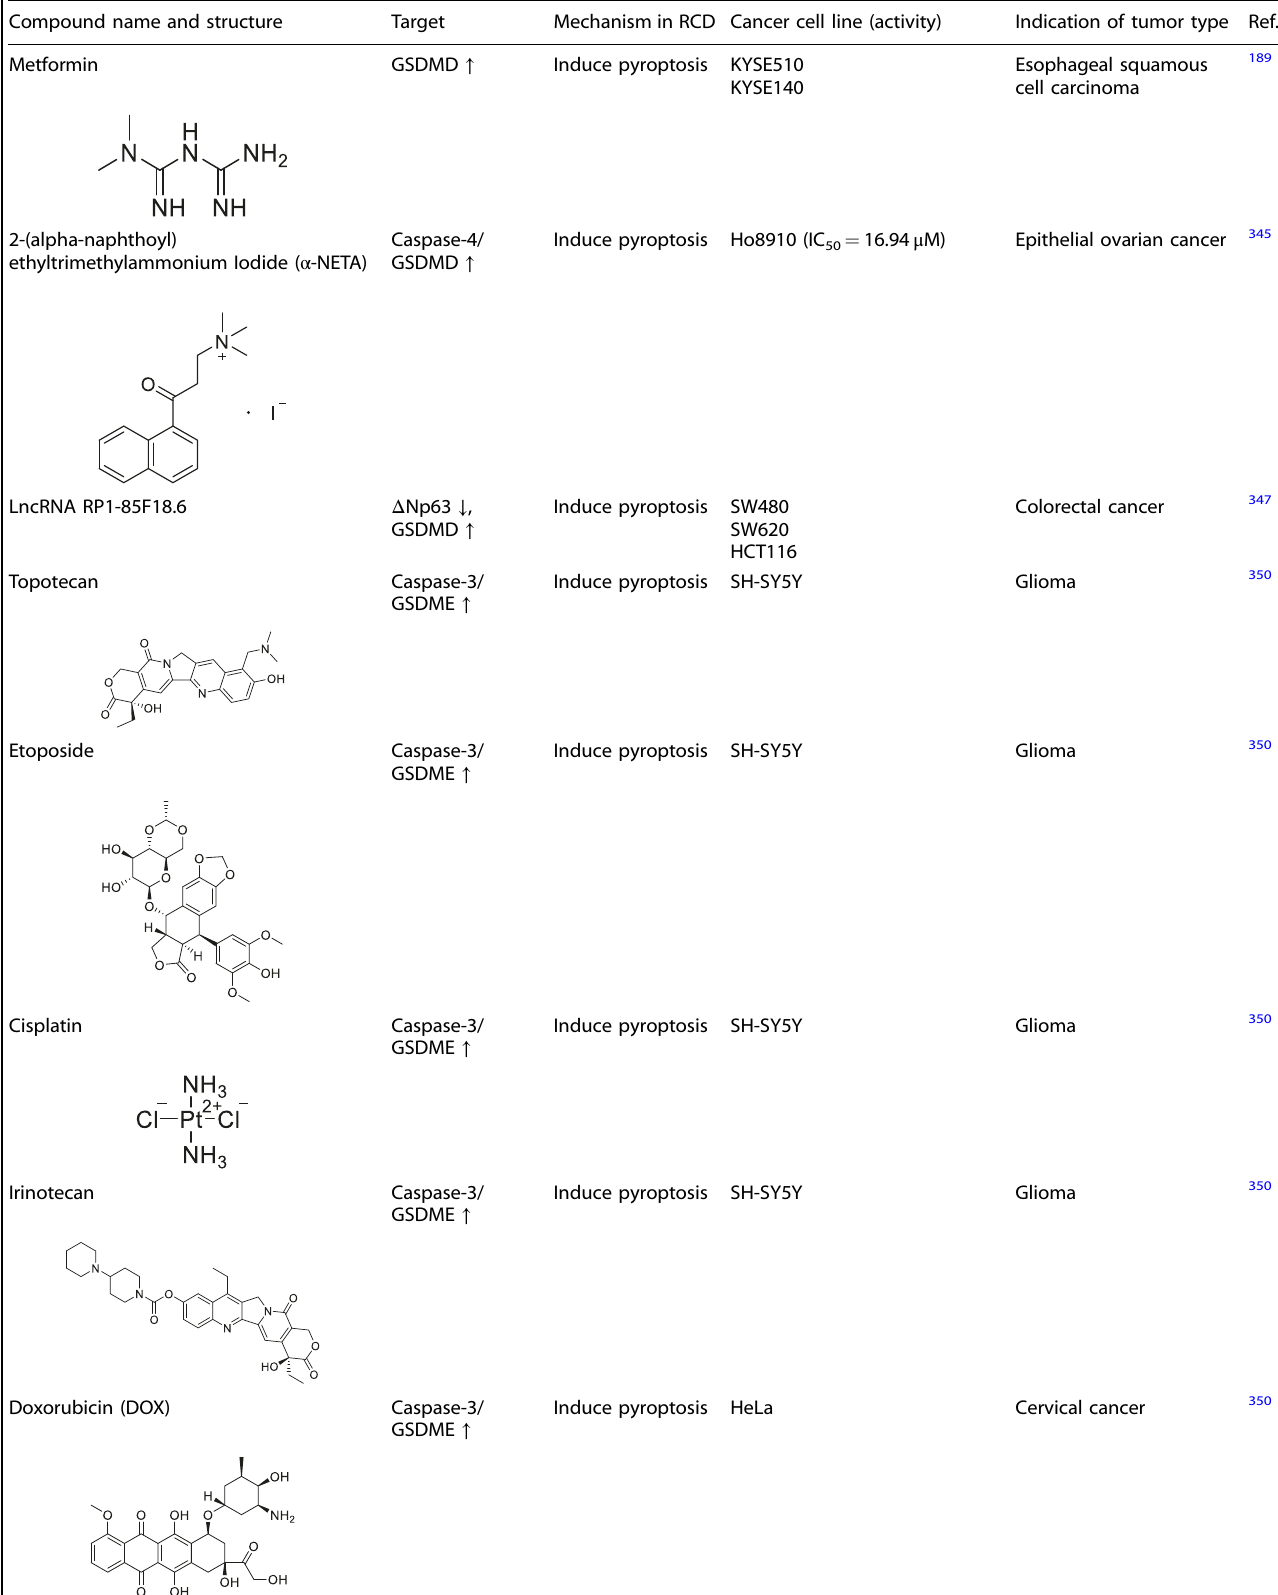
Table 11. Compounds targeting Caspase-1/-4/-5/-11/GSDMD, Caspase-3/GSDME and other targets of pyroptosis in